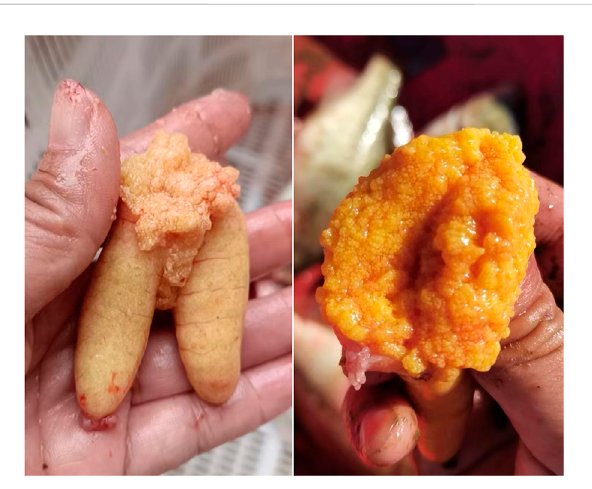
FIGURE 12 Ovary reached maturation on 8 October, 2022, in the largemouth bass individuals that were produced during October and December of the last year. The out-of-season spawning produced largemouth bass that underwent 20 ° C – 28 ° C water temperature and natural photoperiod during their lifetime before reaching maturation. Photos were taken by Ze-Xiao Zhou, an out-of-season spawning-produced largemouth bass